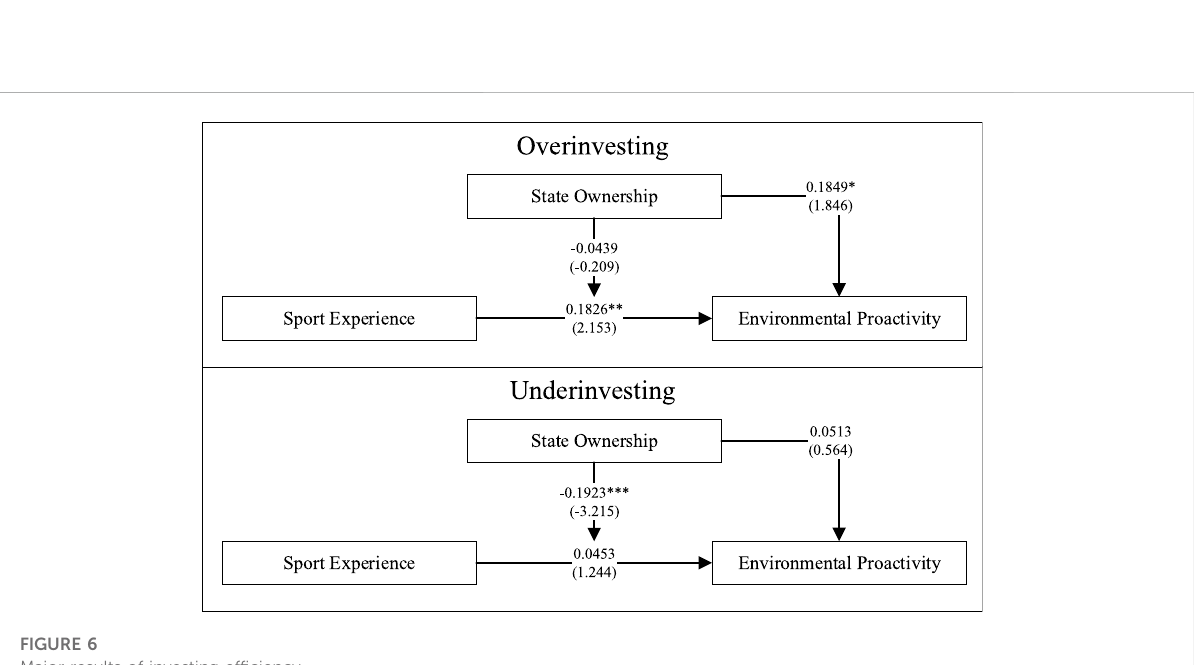
FIGURE 6 Major results of investing ef fi ciency.